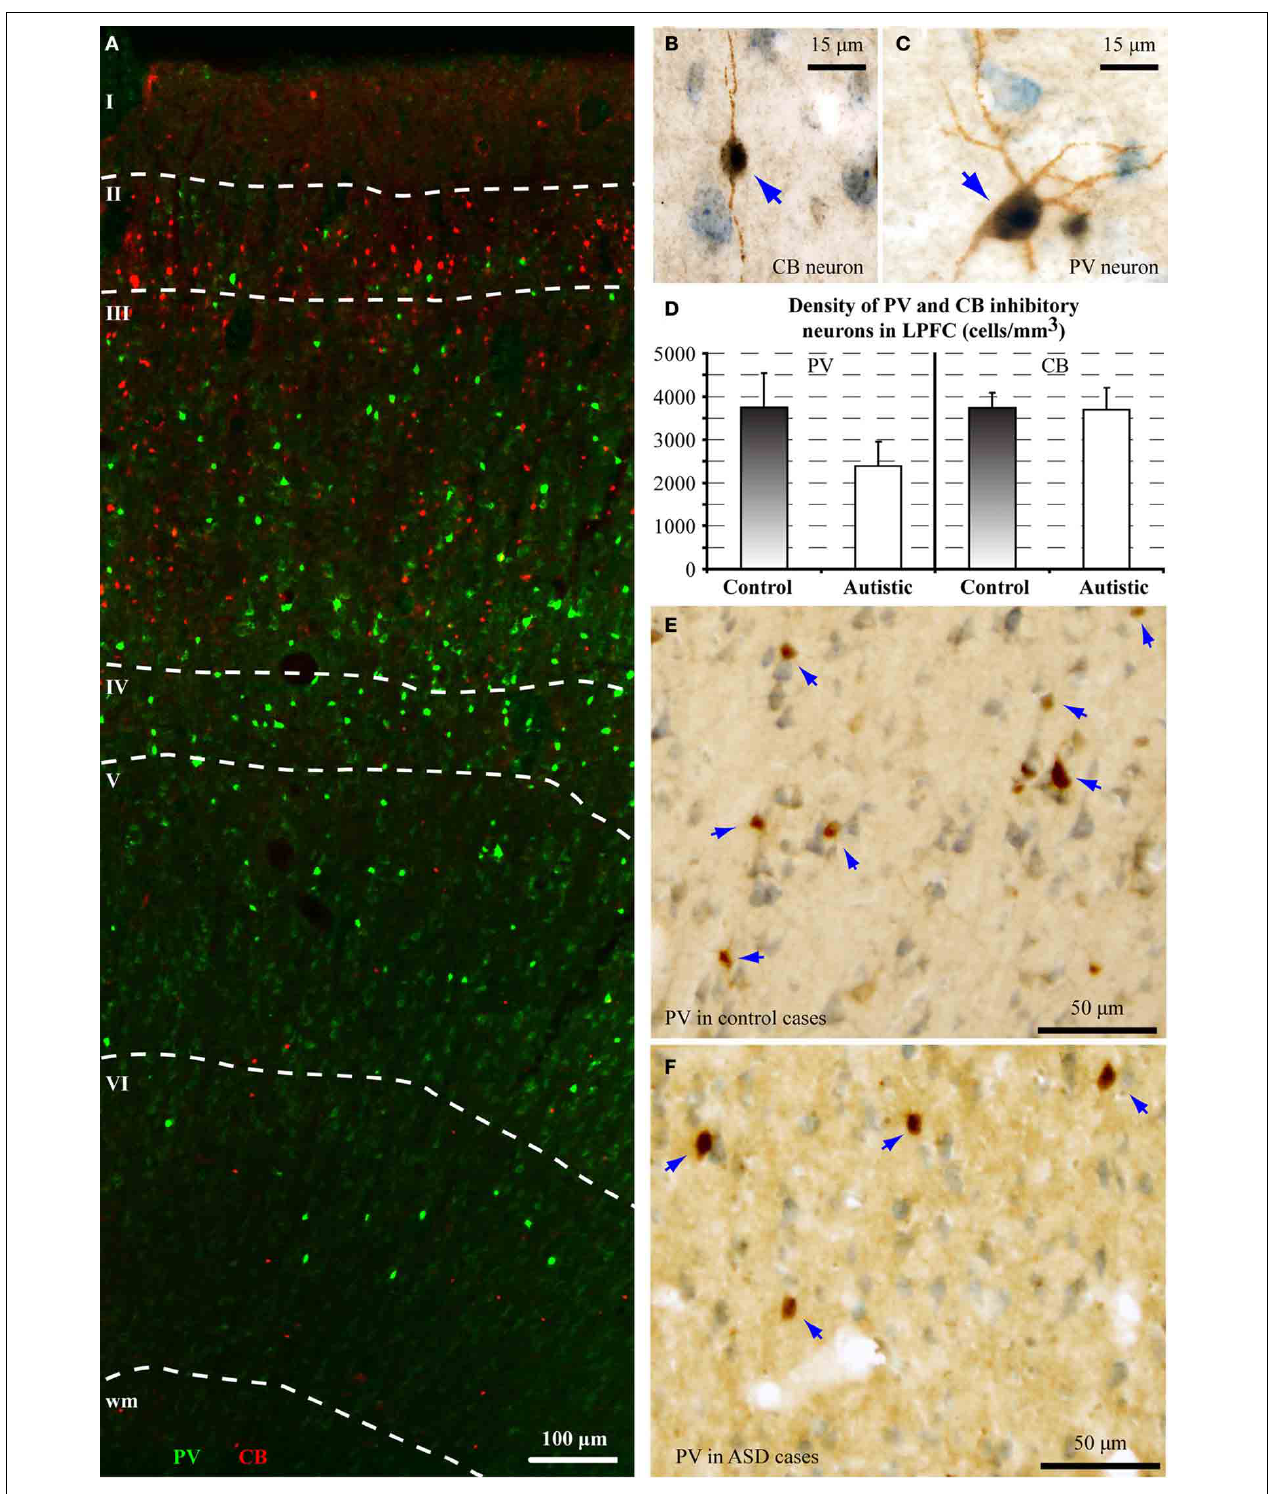
FIGURE 4 | There is a decrease in the ratio of parvalbumin (PV) to calbindin (CB) inhibitory neurons in area 9 of the human brain in autism. (A) Fluorescent photomicrograph shows the preferential laminar distribution of CB (red) in the superficial layers and PV (green) in the middle-deep layers of the human dorsolateral prefrontal cortex. (B,C) High magnification